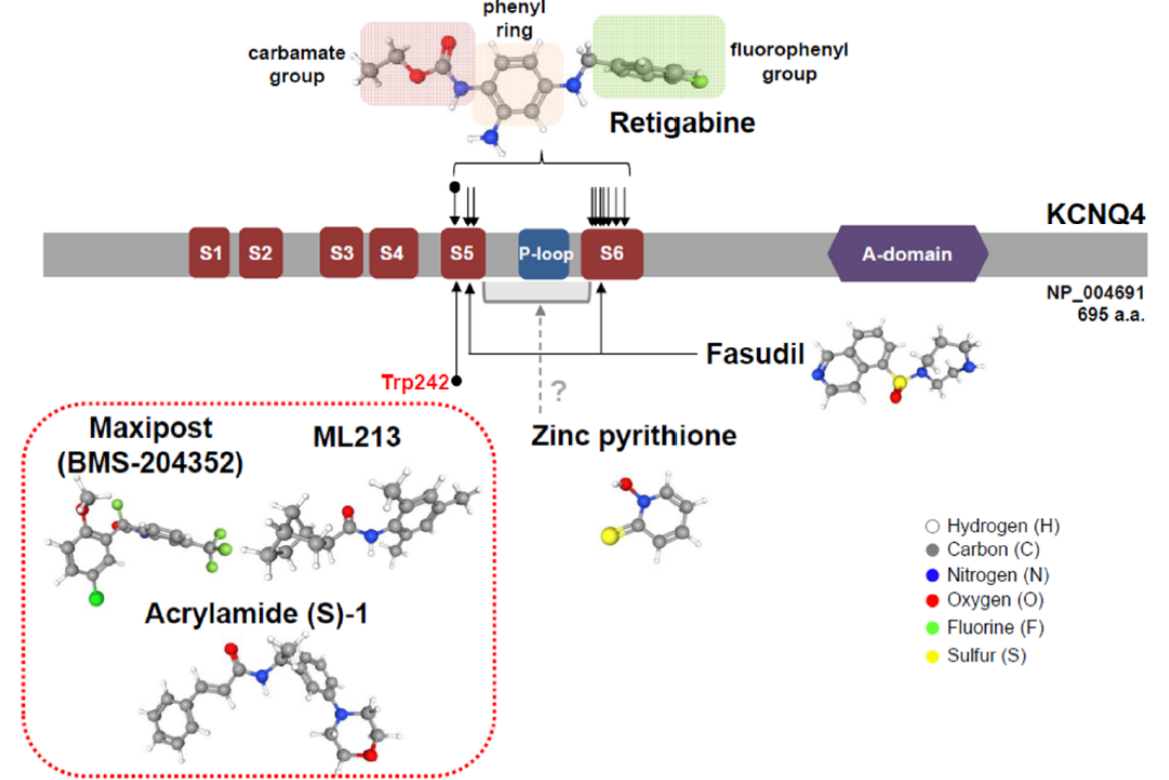
Figure 2. Pharmacological action sites of KCNQ4 activators along functional domains. Critical amino acid residues for the action of KCNQ4 activators are mostly located in the S5 and S6 regions, including the crucial site Trp242. Retigabine, maxipost, acrylamide (S)-1, and ML213 require this tryptophan residue for their